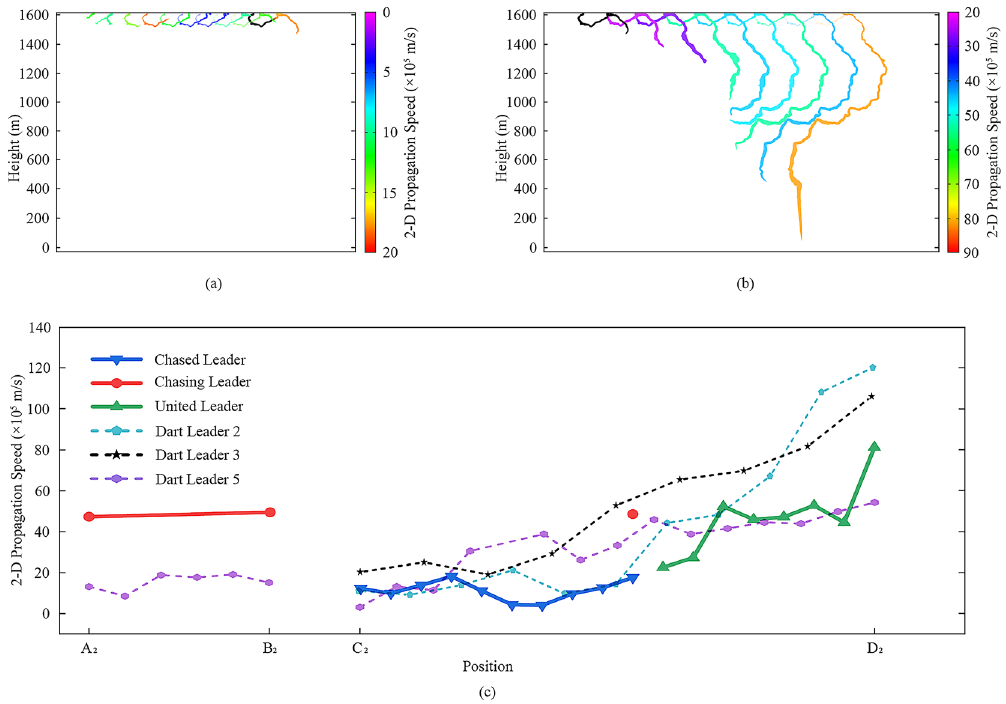
Figure 5. Propagation speeds of leaders in Case II. ( a ) The speed-position figure of the chased leader II. ( b ) The speed-position figure of the united leader II. ( c ) The propagation speeds variation of the chased leader II, chasing leader II, and united leader II, with three dart leaders as